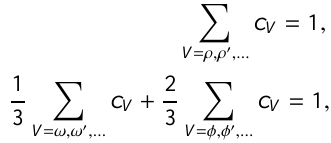
Figure 3. Left panel: The e + e − K + K − and e + e − K S K L cross sections. Right panel: The τ − → → K − K 0 ν τ di ff erential decay rate as a function of the K − K 0 invariant mass. The dashed and solid curves represent the results of the fit with Model I and Model II described in the text,